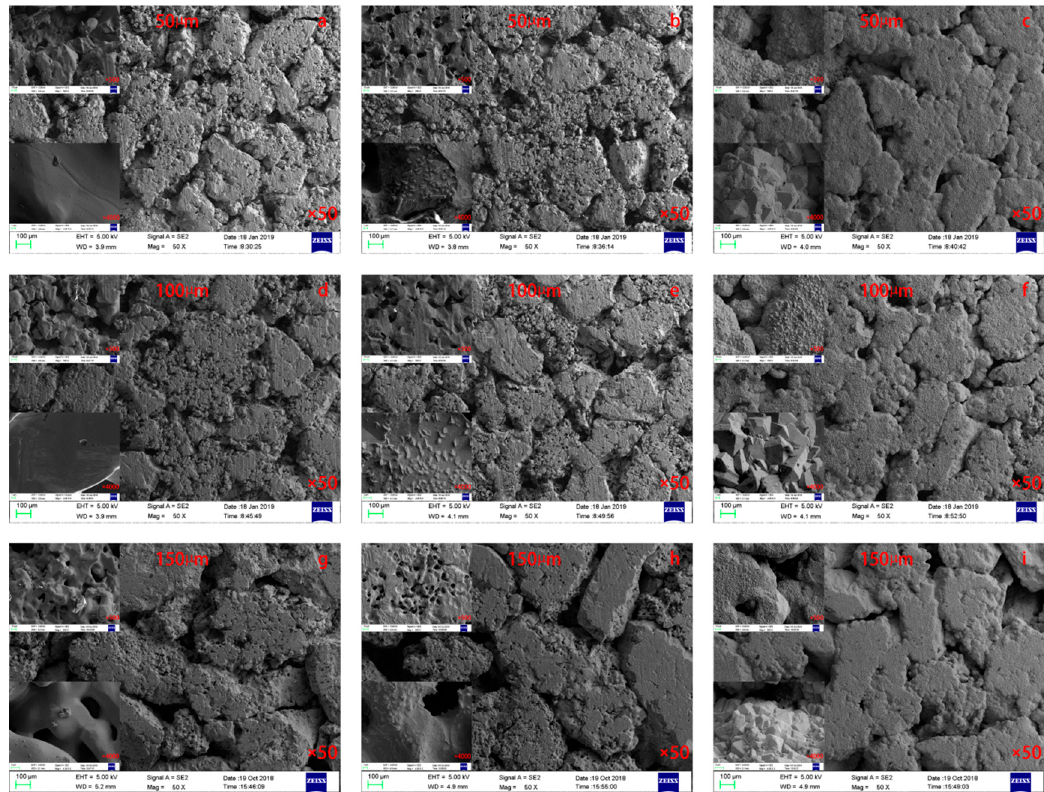
Figure 1. Scanning electron microscopy (SEM) images: ( a ) 50 µm porous Ti substrate; ( b ) 50 µm porous Ti/SnO 2 –Sb 2 O 3 electrode; ( c ) 50 µm porous Ti/SnO 2 –Sb 2 O 3 /PbO 2 electrode; ( d ) 100 µm porous Ti substrate; ( e ) 100 µm porous Ti/SnO 2 –Sb 2 O 3 electrode; ( f ) 100 µm porous Ti/SnO 2 –Sb 2 O 3 /PbO 2 electrode; ( g ) 150 µm porous Ti substrate; ( h ) 150 µm porous Ti/SnO 2 –Sb 2 O 3 electrode; ( i ) 150 µm porous Ti/SnO 2 –Sb 2 O 3 /PbO 2 electrode.